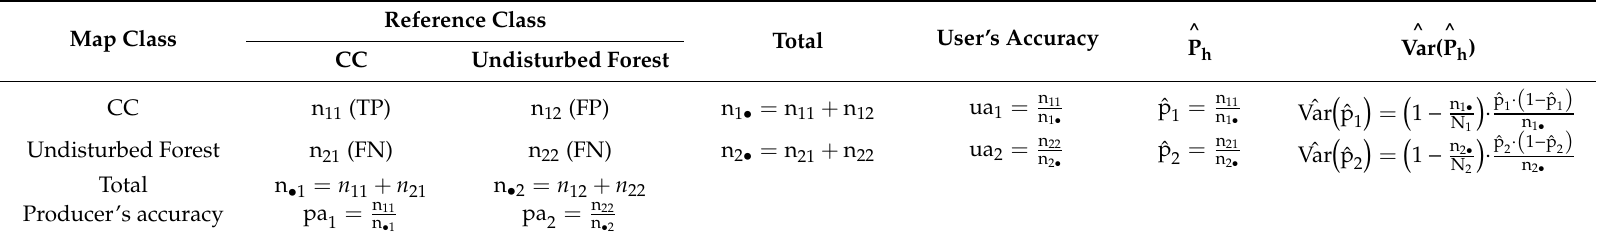
Table 2. Confusion matrix ( N h in the last column is the total number of map units in the h th map